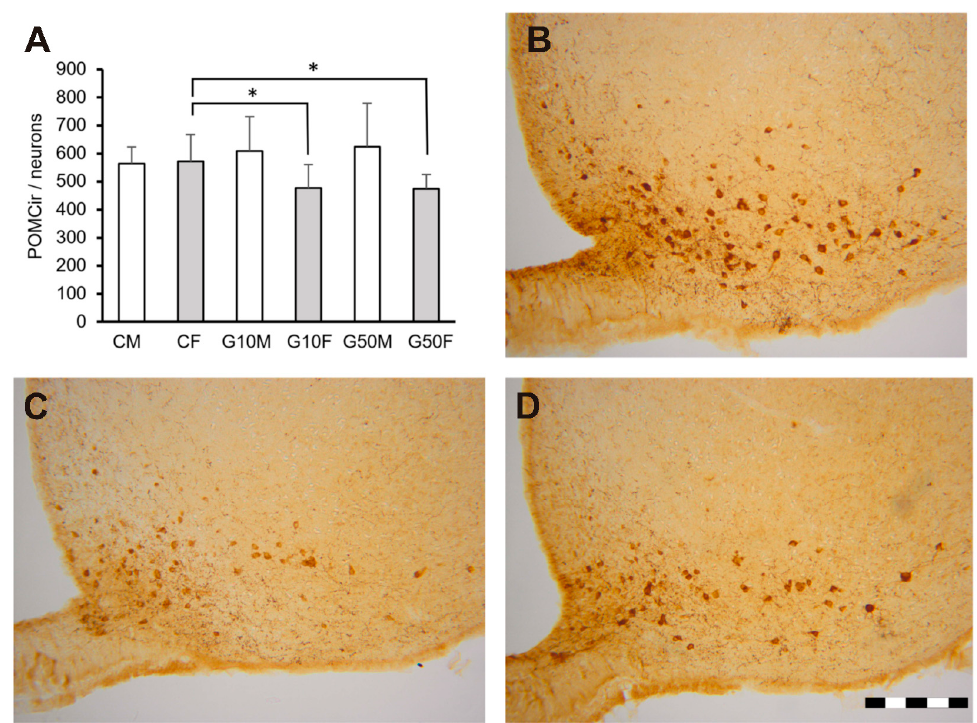
Figure 3. Graph ( A ) showing the number of POMC-ir neurons in ArcM in all experimental groups (two-way ANOVA) * indicates differences between groups ( p < 0.05 in all cases). The error bars indicate standard error of the mean. CM: control males; CF: control females; G10M: genistein treated males, dose 10 µ g/g; G10F: genistein treated females, dose 10 µ g/g; G50M: genistein treated males, dose 50 µ g/g; G50F: genistein treated females, dose 50 µ g/g. n = 6 in all groups. All treatments, either injection of genistein or vehicle, were administered from P6 to P13. ( B – D ) photomicrographs showing the distribution of POMC-ir positive cells in Arc nucleus. B = control female, C = G10 female, D = G50 female. Bar = 200 µm. .[44].